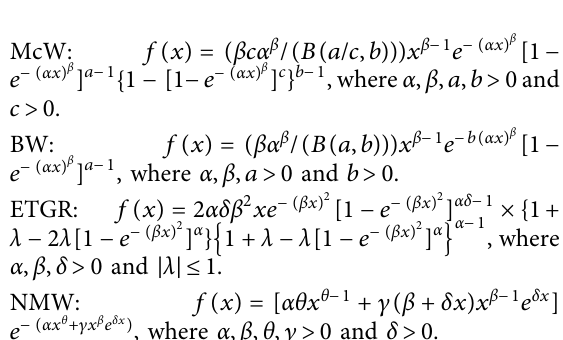
Figure 3: The estimated SF and PP plot of the TIHLIW model.